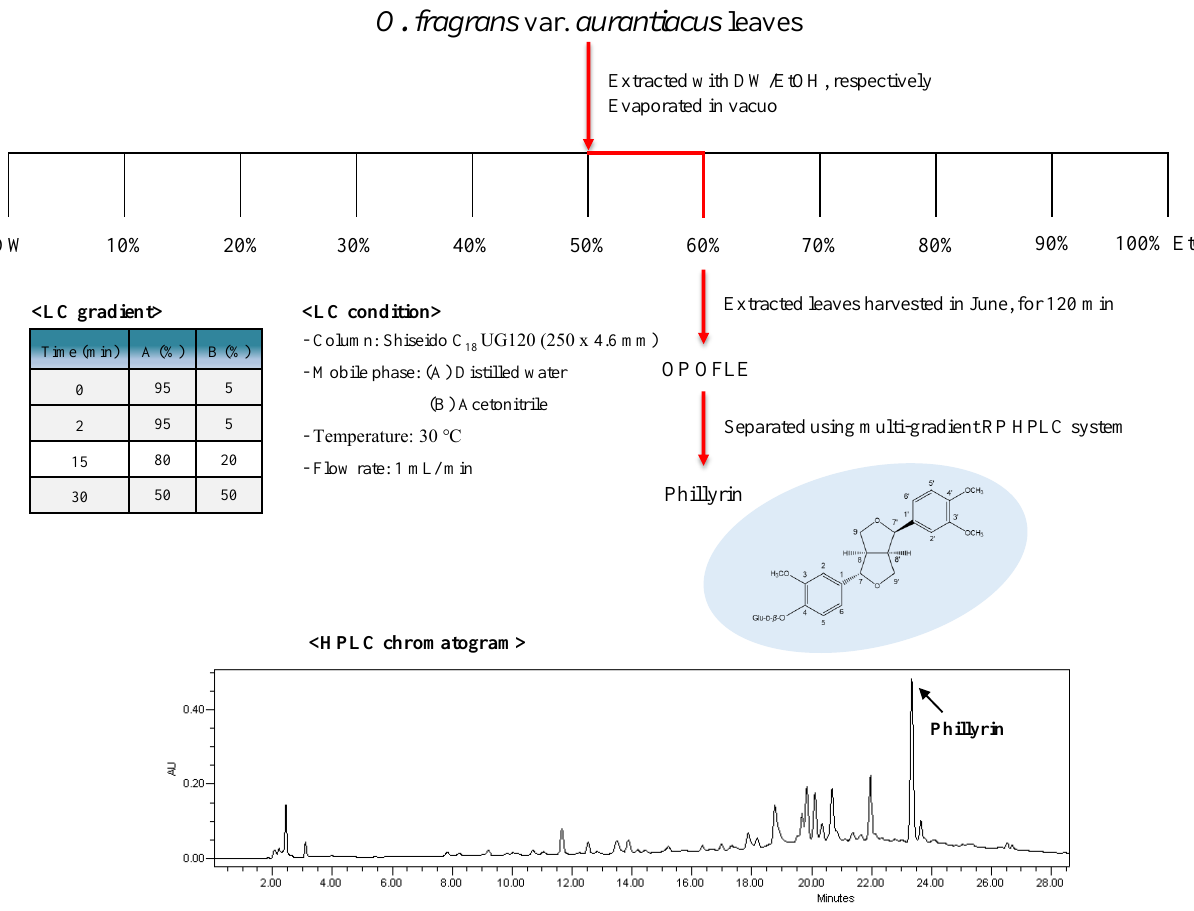
Figure 6. Isolation scheme and structure of PH isolation from OP OFLE.